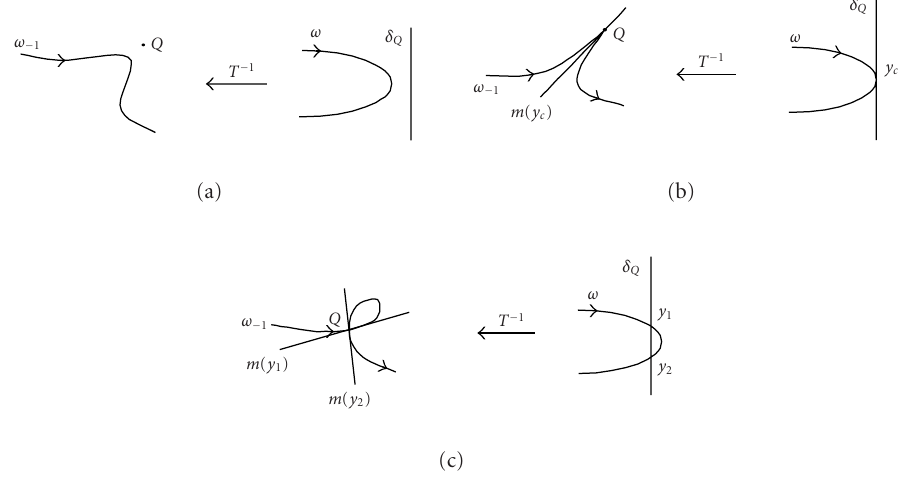
Figure 3.2. Image under T − 1 of a smooth curve ω after crossing through δ Q